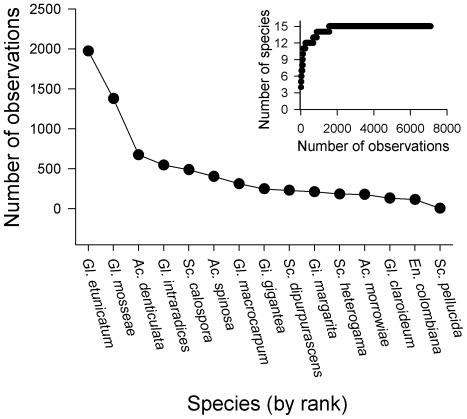
The frequency of AM fungal species across the 50 m×50 m sampled grid and a species rarefaction curve (inset).